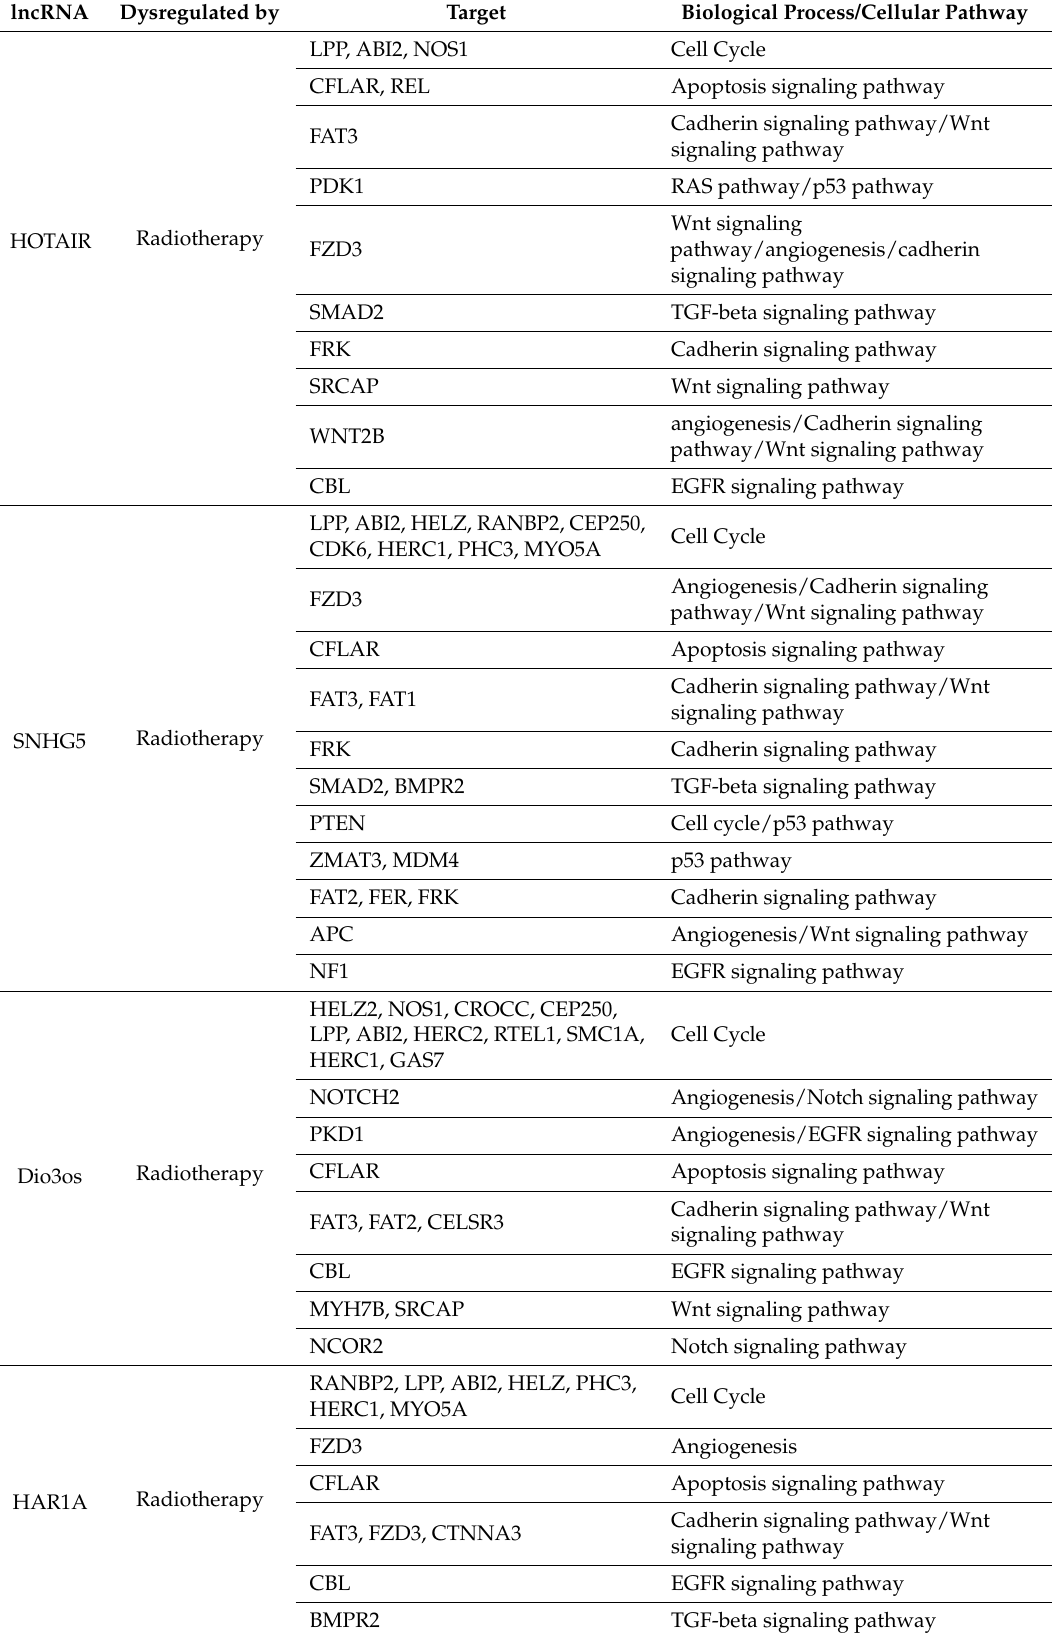
Table 7. Predicted molecular interactions of dysregulated lncRNAsafter irradiation or chemoexposure.